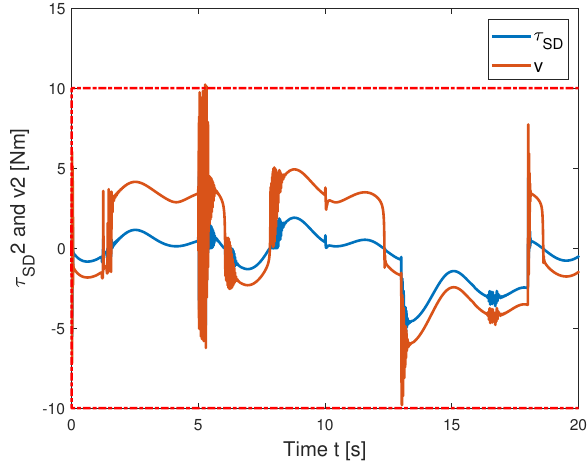
Figure 6. Control inputs τ SD and v for the second joint (MB control).